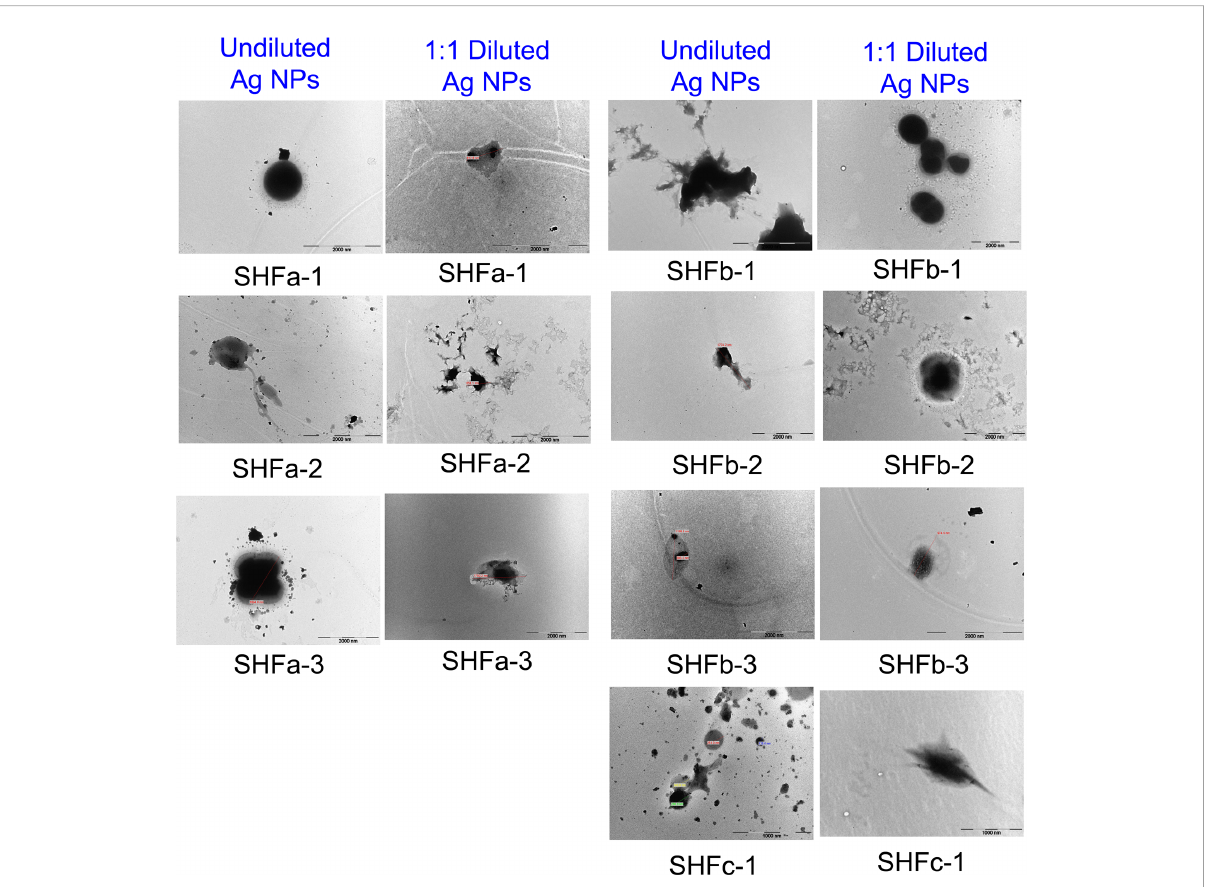
FIGURE 6 Representative TEM images of E. faecium 1449 cells treated Ag-hydrosol NPs. Scale bar = 1000 nm for SHCc-1 samples. Scale bar = 2000 nm for all other